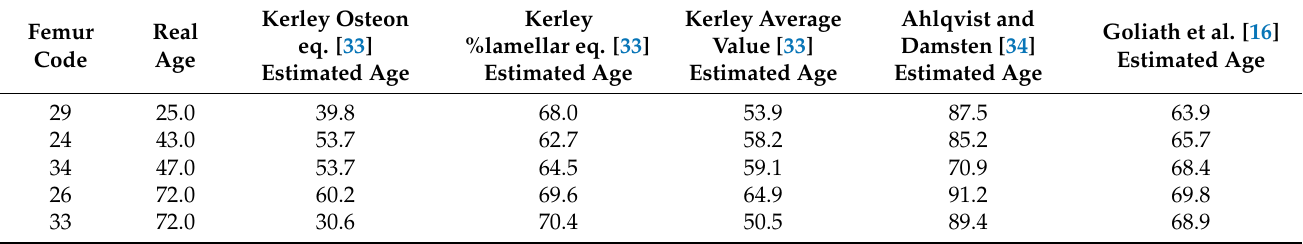
Table A2. The known and estimated age for each femur specimen by the age-estimation methods. Femur